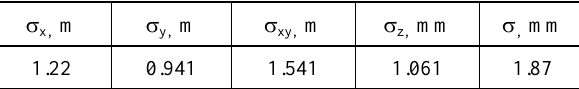
Table 3. Camera position precision